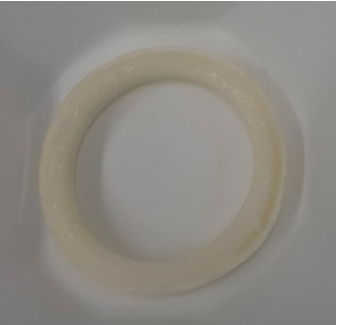
Figure 2. Image of the manufactured samples.